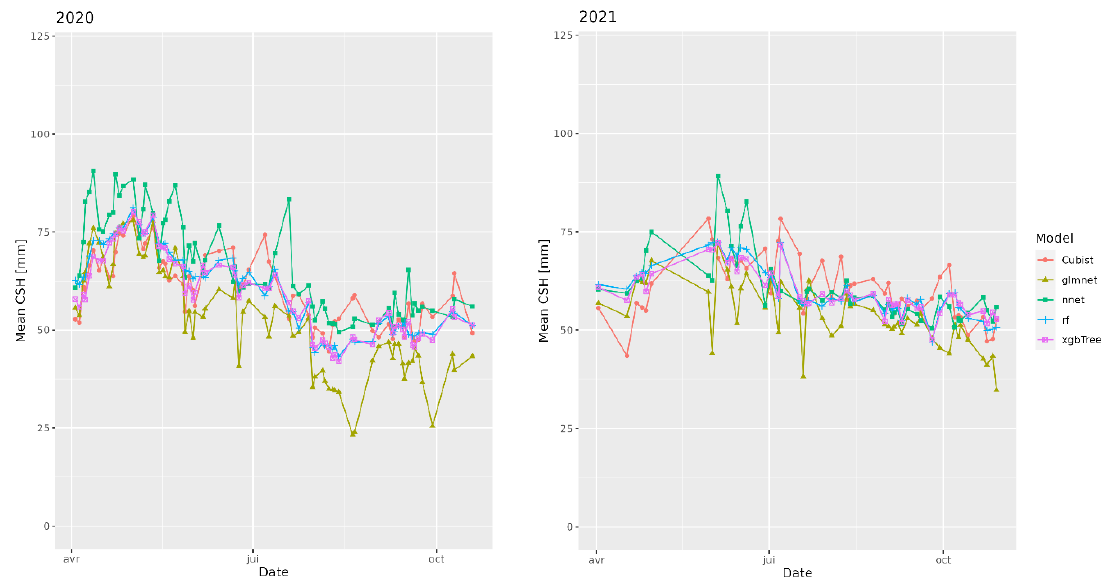
Figure 6. Mean per date of acquisition of the mean per parcel of the CSH predicted at the pixel level.